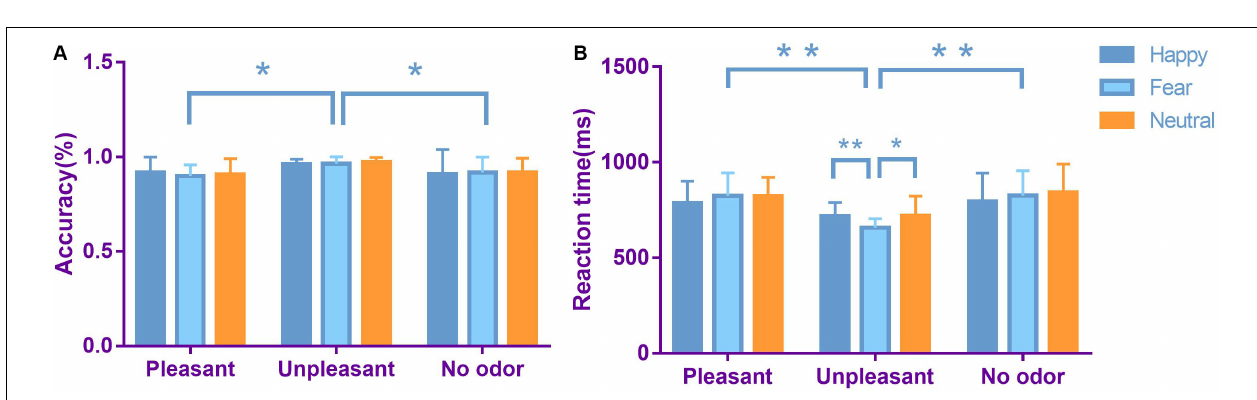
FIGURE 3 | Average accuracy (A) and average reaction time (B) in each odor × expression condition (bars represent SE). * p < 0.05, ** p < 0.01.